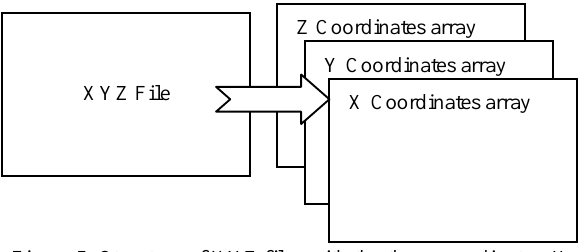
Figure 5: Structure of XYZ files with the three coordinates: X, Y and Z.